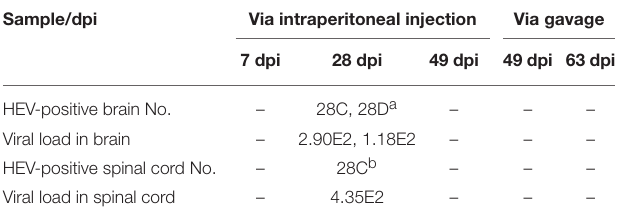
TABLE 1 | Viral load detection in brain and spinal cord of experimentally infected